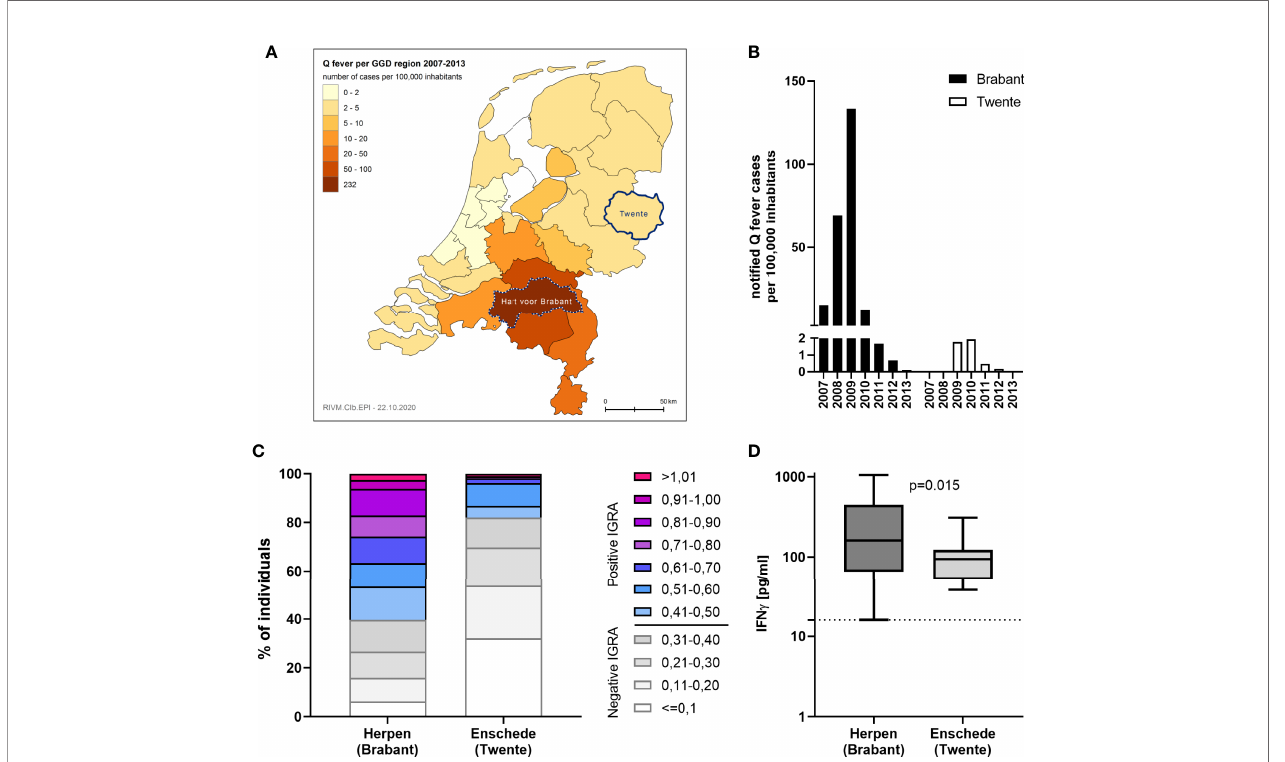
FIGURE 6 | IGRA results in areas with past high and low Q fever prevalence. C. burnetii -speci fi c responses were assessed by IGRA via stimulation with Cb2629 in n=804 individuals in the high prevalence area of Herpen and the low prevalence area of Enschede in 2014. (A) Map showing the cumulative incidence of noti fi ed Q fever cases per 100,000 inhabitants from 2007-2013 in the different Municipal Health Service (GGD) regions. The GGD regions where Herpen (Hart voor Brabant) and Enschede (Twente) are located, are highlighted. (B) Yearly incidence of noti fi ed Q fever cases per 100,000 inhabitants in the years 2007-2013 in the GGD regions Hart voor Brabant and Twente. (C) CoxRRs for all individuals are shown. (D) Background corrected C. burnetii -speci fi c IFN g responses are shown for n= 482 individuals in Herpen and n=19 in Enschede, who scored positive by IGRA. Responses were compared by Mann-Whitney rank test. The dashed line indicates the positivity cut-off of 16 pg/mL for C. burnetii speci fi c IFN g